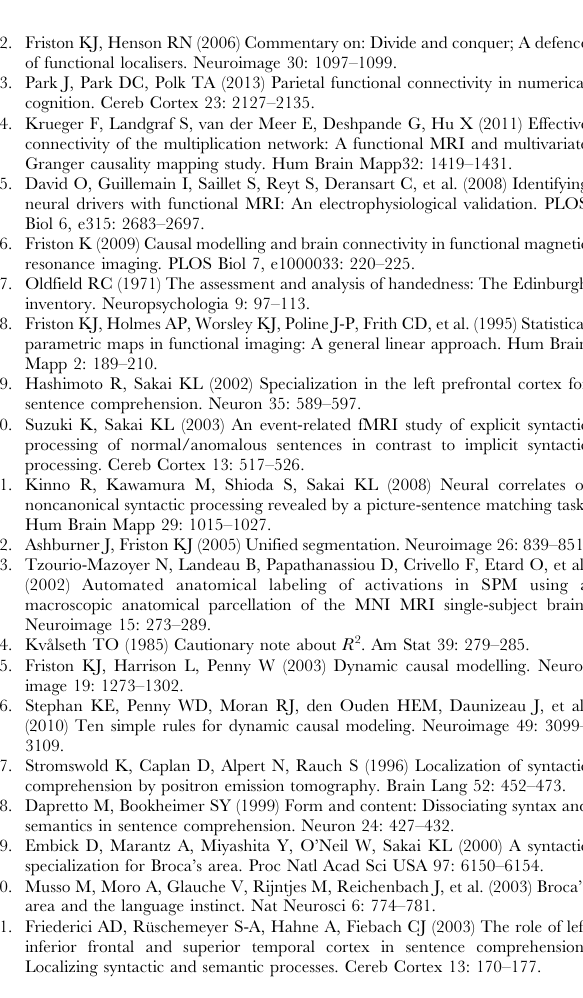
Figure S1 Models tested in the dynamic causal model-